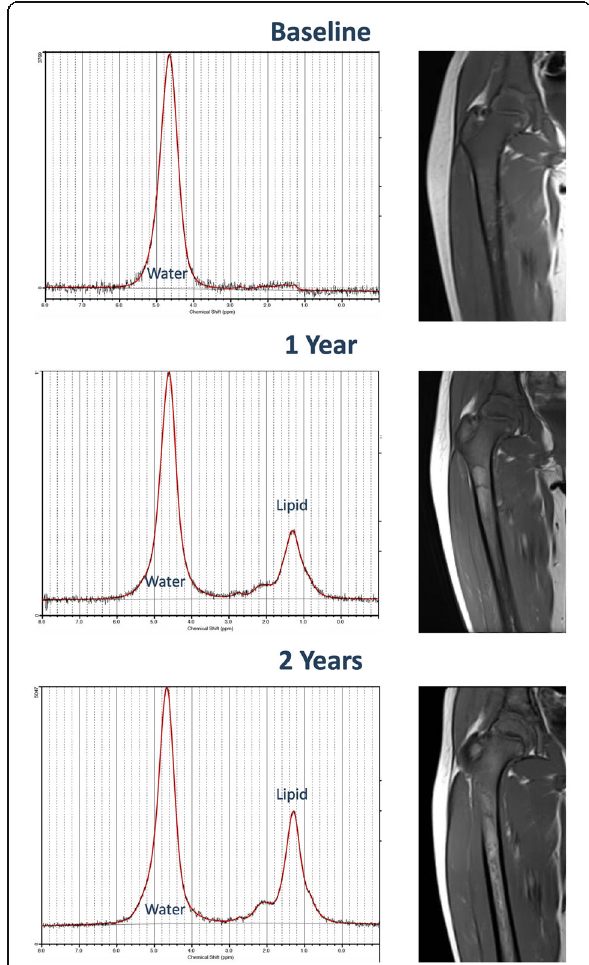
Fig. 9 Magnetic resonance spectroscopy assessment of marrow response to treatment. Gaucher disease patient with first imaging at 15 years of age subsequently treated with ERT. Magnetic resonance spectroscopy spectra (left) show increasing fat-fraction on follow-up examinations. Conventional T1-weighted coronal images (right) of the right femur demonstrate diffuse marrow infiltration with subtle fat infiltration with